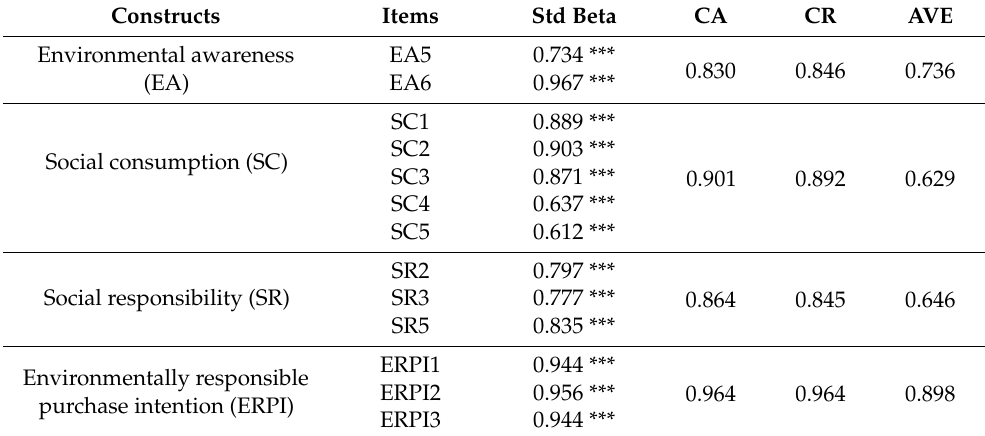
Table 4. Scale items, factor loadings, composite reliabilities and average variance